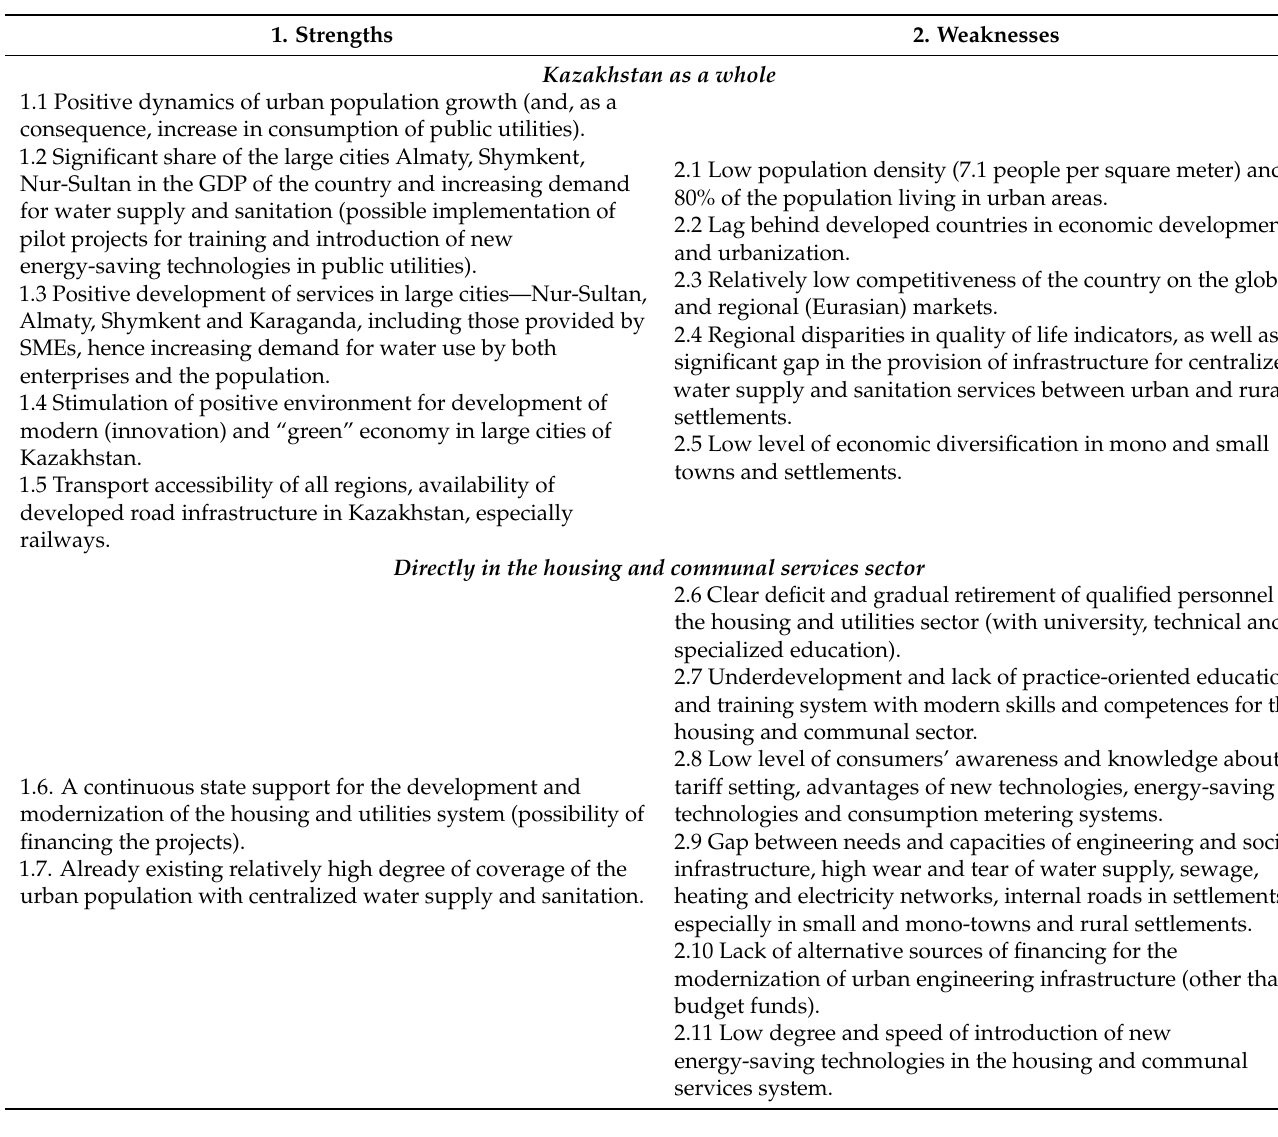
Table 11. SWOT-analysis of the development of the housing and communal services sector in